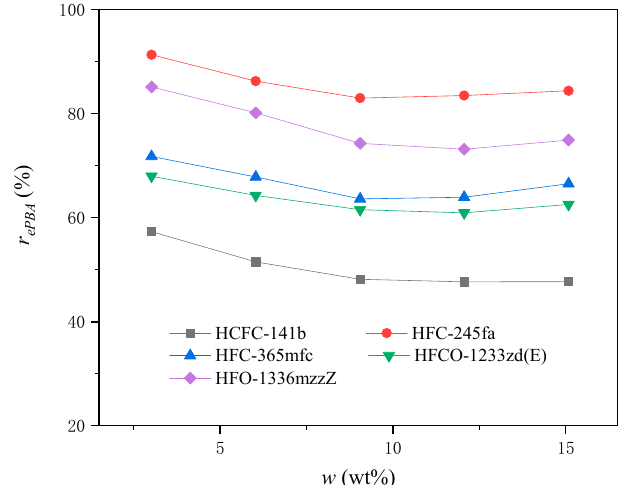
, (cid:3280)(cid:3265)(cid:3251)(cid:3250)